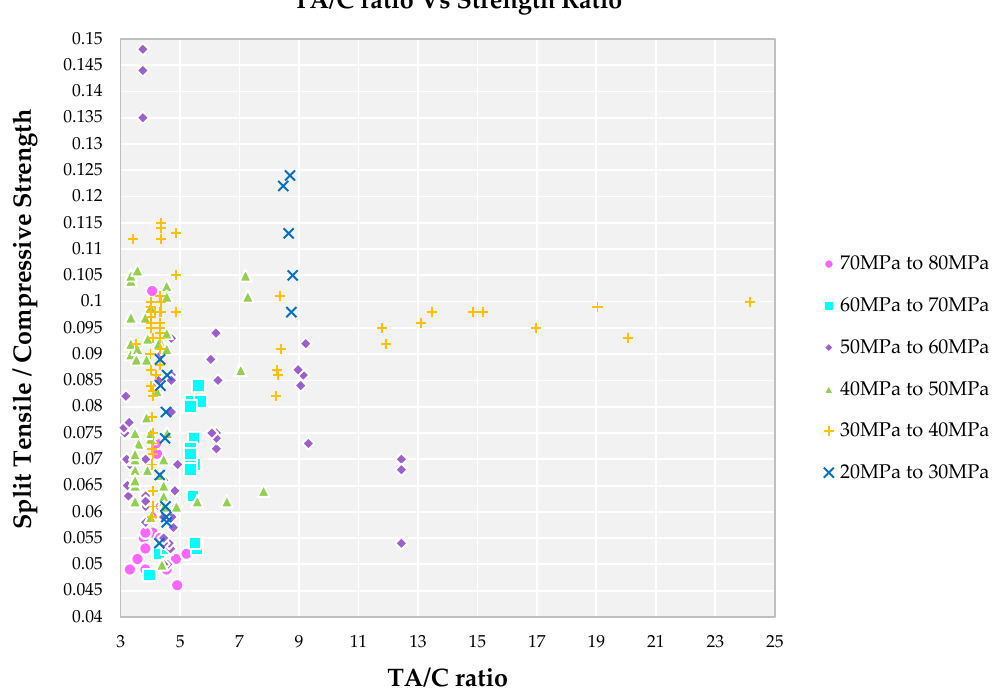
Figure 5. Impact of TA/C ratio on split tensile strength to compressive strength ratio for different grades of SCC concrete with recycled aggregate according to literature.